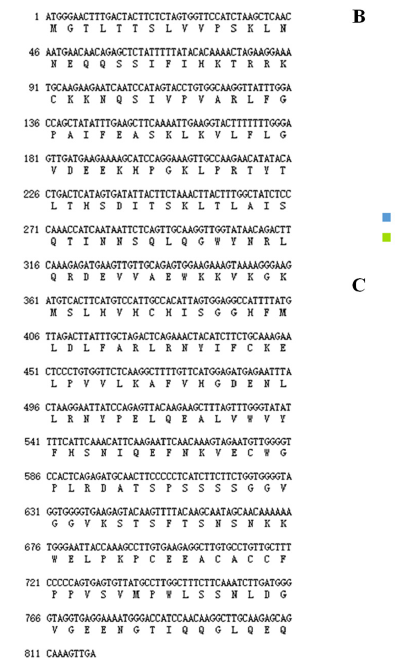
Figure 4. Phylogenetic tree of SlSGR2 proteins.